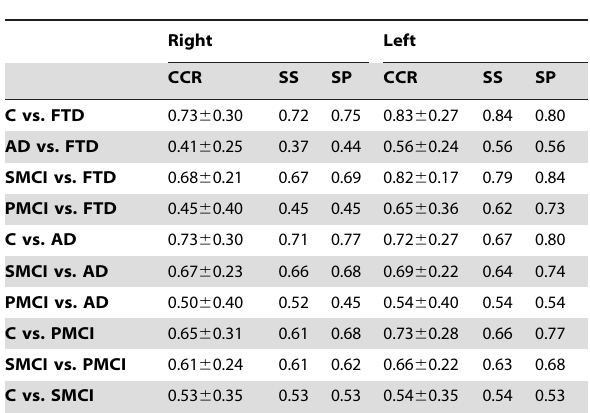
Table 3. Hippocampal